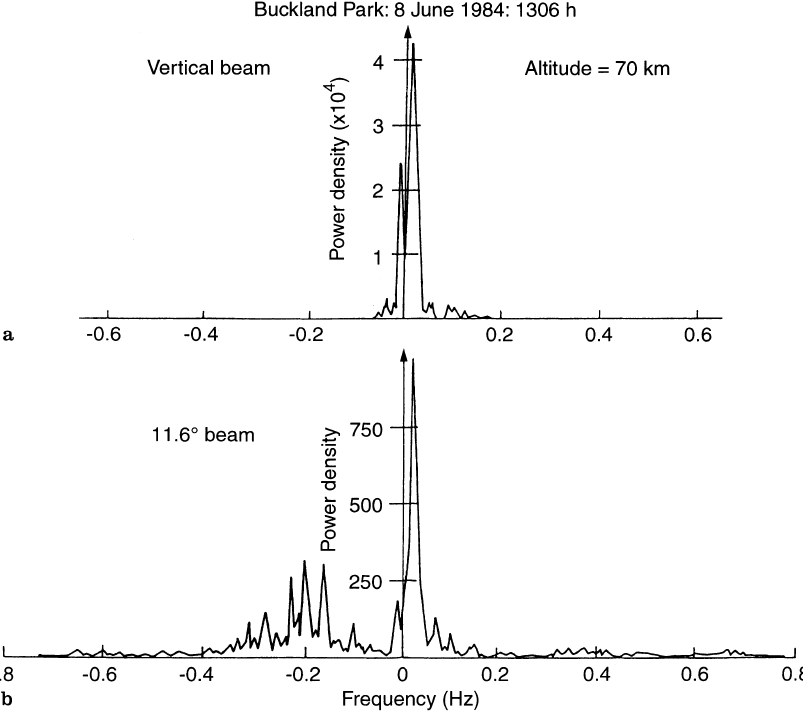
Fig. 5a, b. This figure, from Hocking (1987), demonstrates the temporally simultaneous occurrence of specular reflectors and tur- bulence scatter in the atmosphere, a vertical radar beam, b o(cid:128)-vertical